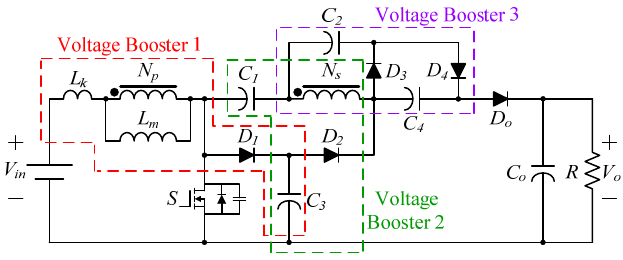
Figure 2. Power circuit of the proposed high step-up converter.